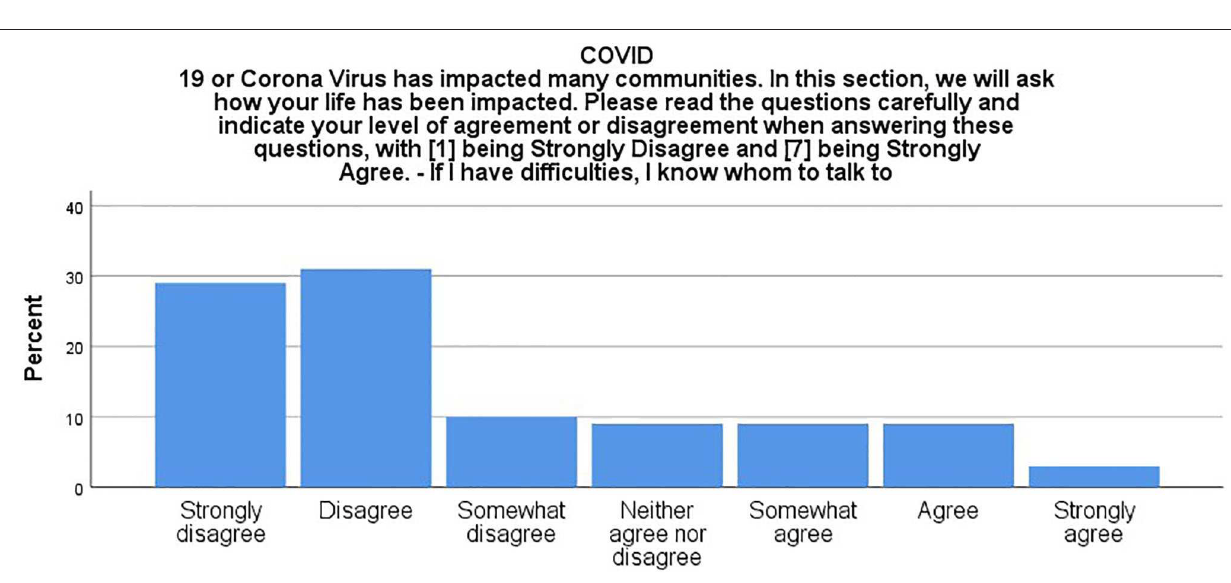
FIGURE 9 | Distribution of participants reporting knowledge of whom to talk to when experiencing